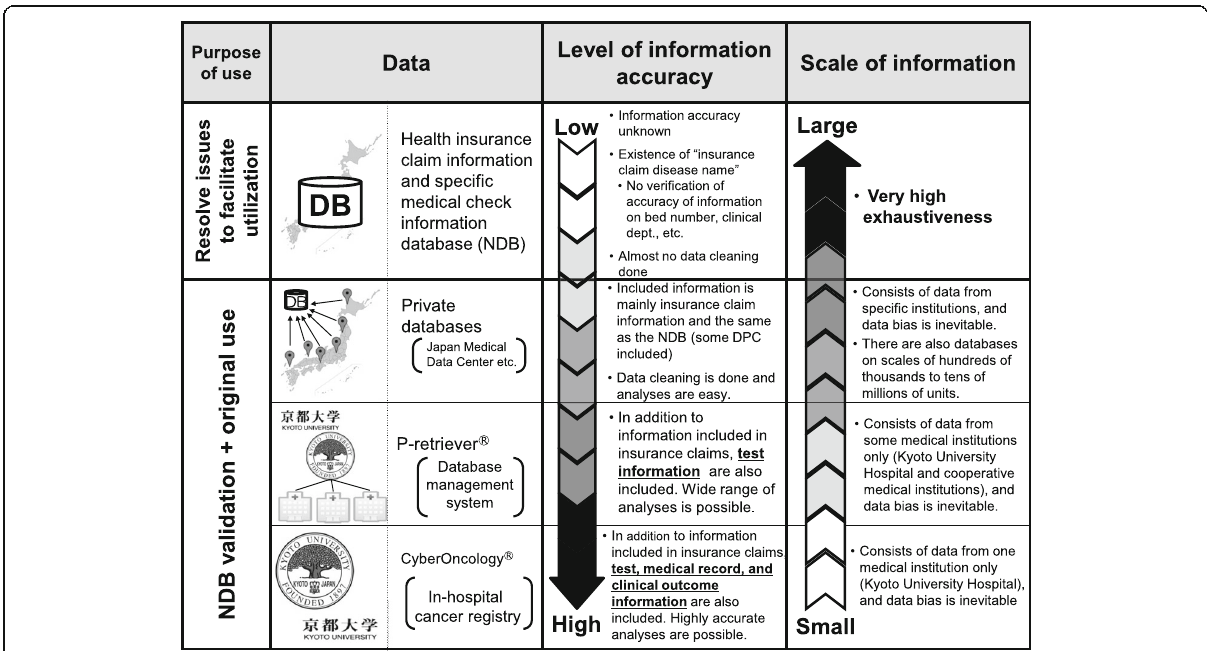
Fig. 1 Characteristics of the data used in this